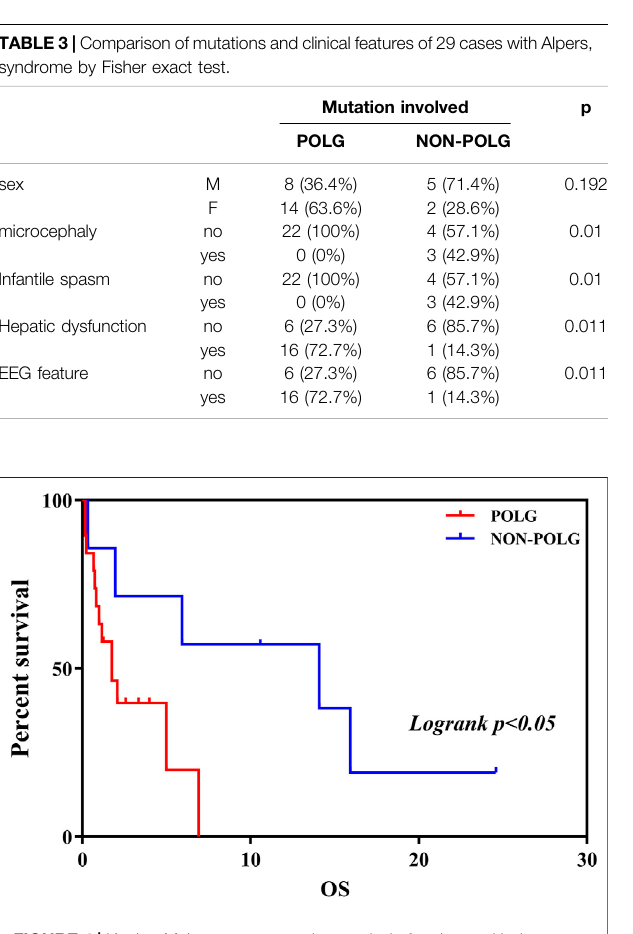
FIGURE 4 | Kaplan-Meier curve comparing survival of patients with the POLG or non- POLG group and patients with POLG Group showed carried signi fi cantly worse